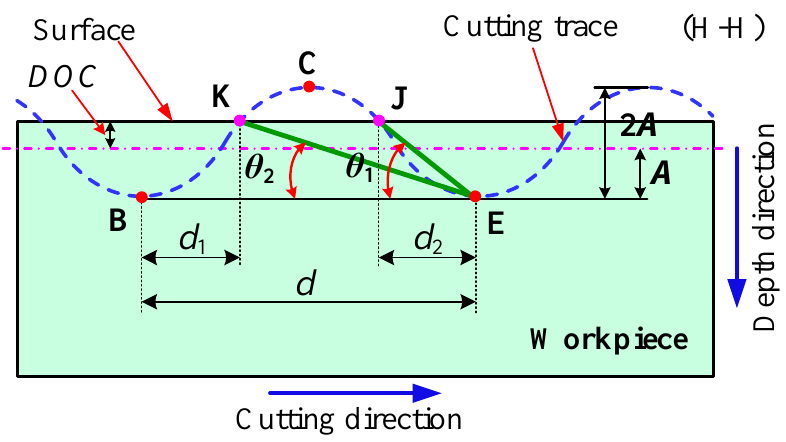
Figure 3. Cutting trace under intermittent cutting condition.